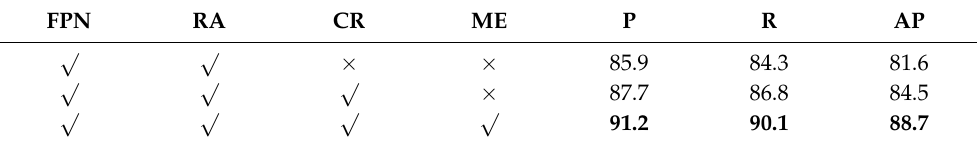
The bold number indicates the best method for each of the examined indexes.